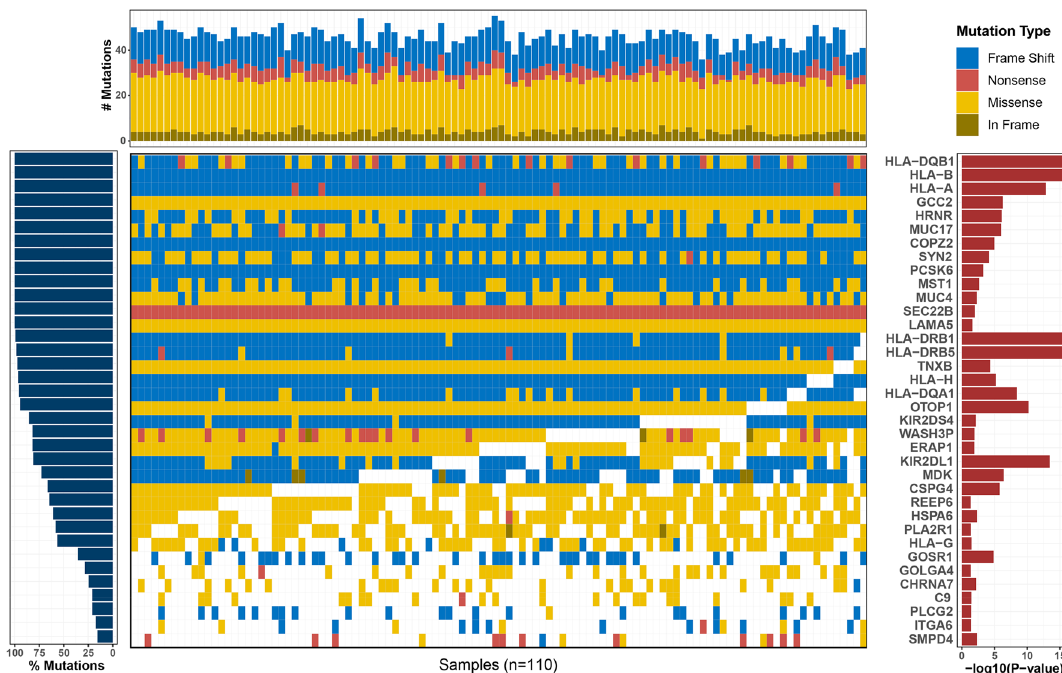
Figure 2. Mutational landscape of 36 candidate genes enriched in GO and KEGG pathways in the IPF samples. Mutation burdens are displayed on the X-axis panel (top), and cohort mutation percentage by a gene is displayed on the Y-axis panel (left). P value from SKAT of each gene is displayed on the Y-axis panel (right). Displayed genes are significantly enriched in the IPF samples. Each column represents an individual sample. Coloring of patient-gene intersection grid indicates mutation type (top